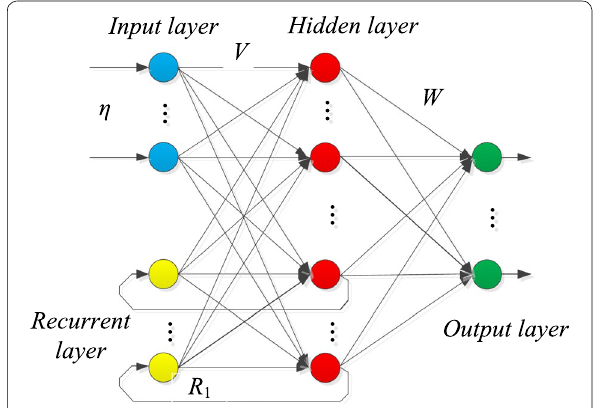
Figure 2 Structure of recurrent neural